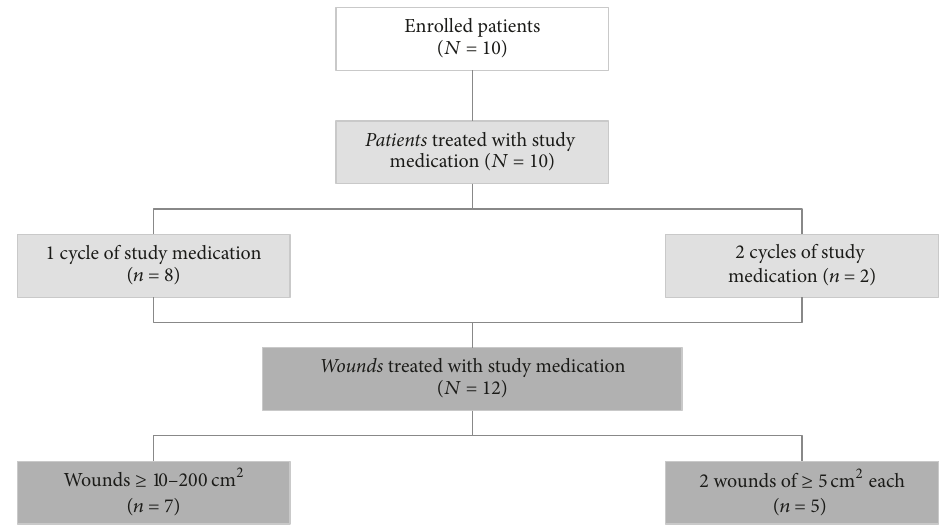
Figure 3: Disposition of